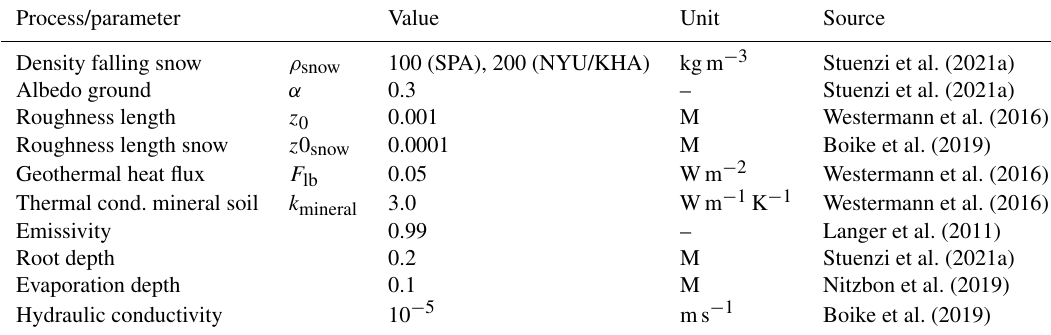
Table C1. Overview of the CryoGrid parameters